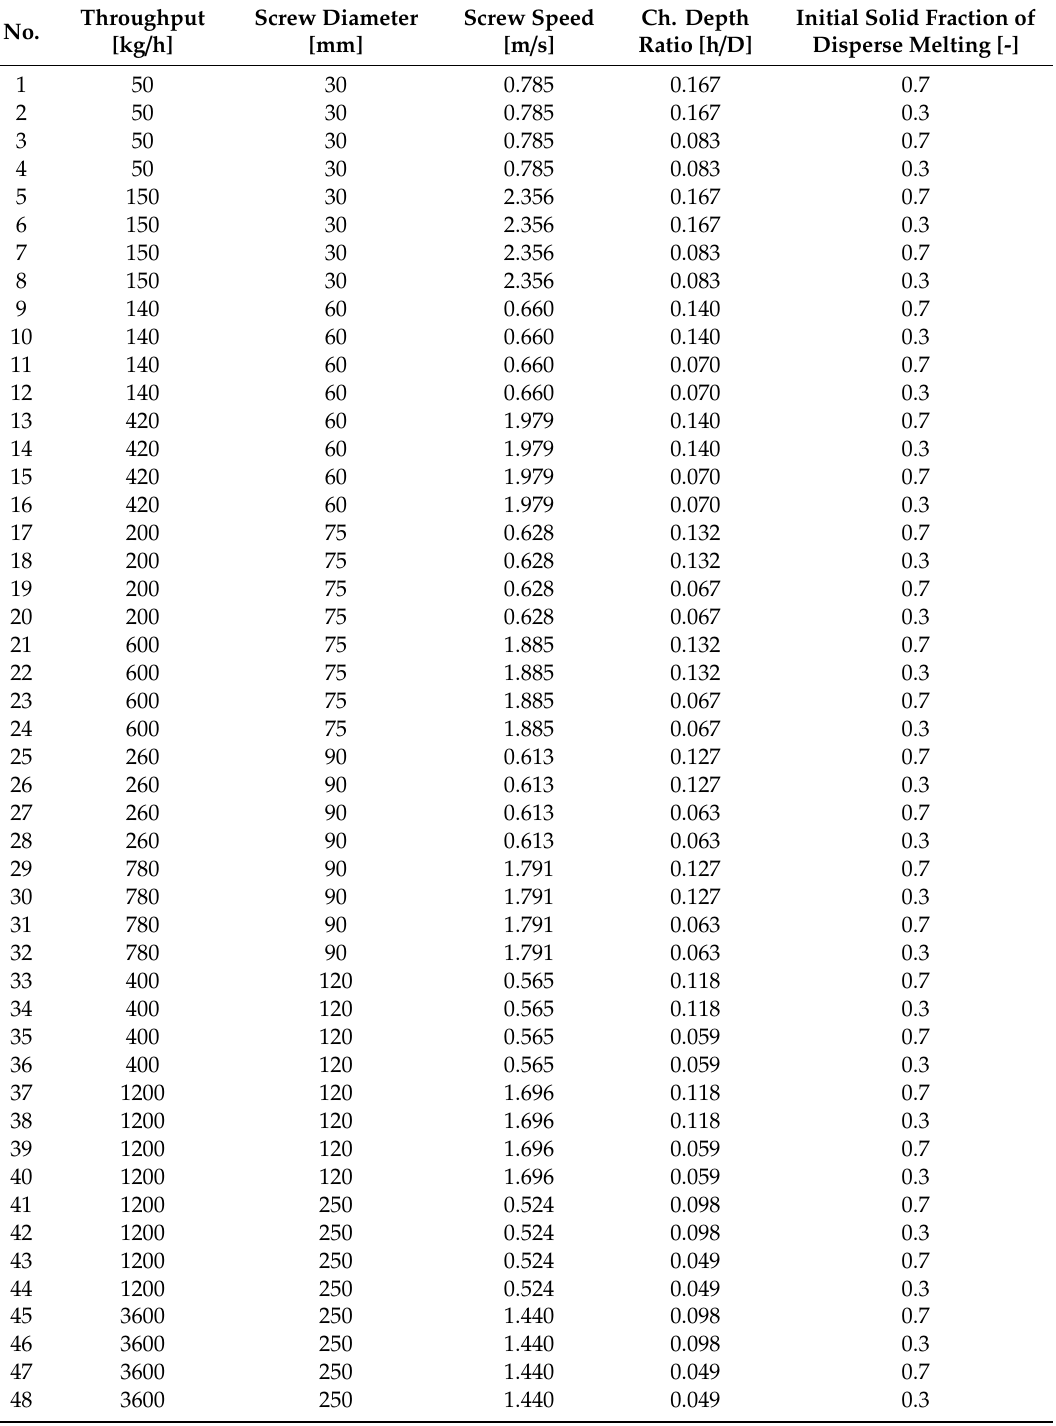
Table A1. Main simulation points of design of